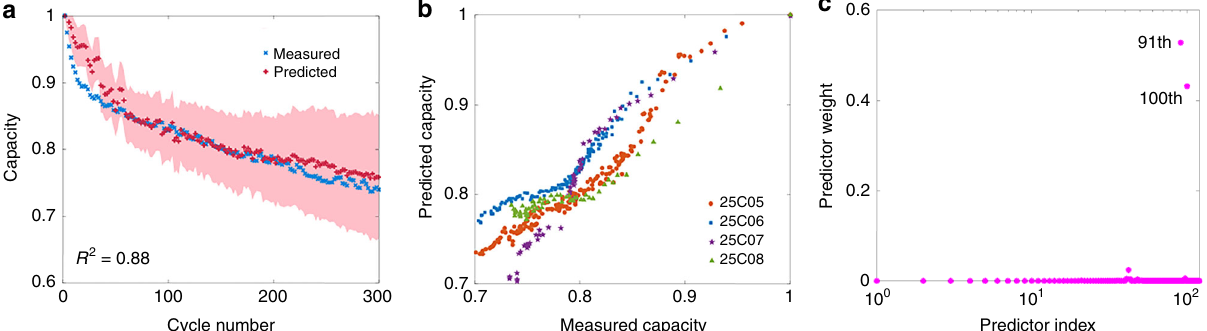
Fig. 1 Estimating battery capacity. a Estimated (red curve) and measured (blue curve) capacity as a function of cycle number for the 25C05 cell. The coef fi cient of determination ( R 2 ) of this model is shown on the left bottom. b The measured capacity against the estimated capacity of all four testing cells cycled at 25 °C. The capacity is normalised against the starting capacity in each case. c ARD shows that the impedance at low frequency is most correlated with degradation. The pink points correspond to the 120 frequencies in the range of 0.02 Hz – 20 kHz. The GPR model assigns the largest weights to the 91st and 100th features, corresponding to 17.80 and 2.16 Hz, respectively. The less relevant features have weights close to